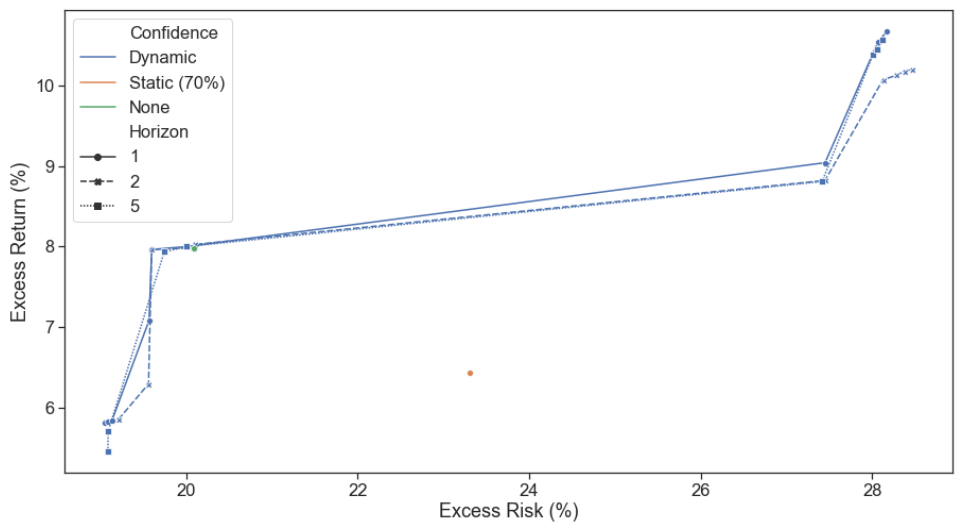
Figure 14. Long EWG and Short SPY View Performance (2005–2020).